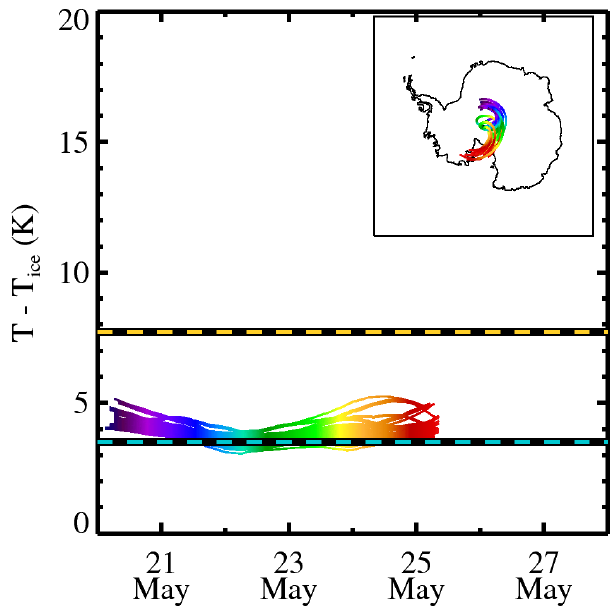
Fig. 9. Trajectory analysis of locations identified as depleted in HNO 3 (less than 9ppbv) on the MLS 46hPa pressure surface over the Ross Sea on 25 May 2008. Isentropic back trajectories are shown for 475K (40hPa) for a five day integration time. The in- set geographical map shows that the likely origin overlies the inner vortex over the South Pole. Colors indicate the time (start (red) and end (purple)) along the trajectory. The corresponding GEOS- 5 synoptic-scale temperature analysis time histories show constant exposure to conditions 2–4K below the NAT existence thresh- old temperature (yellow-black dashed line), with some air masses experiencing temperatures below the STS formation temperature (cyan-black dashed